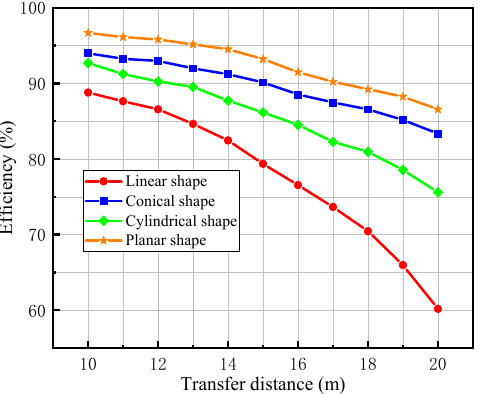
Figure 11. Comparison of transmission efficiency among four transfer structures at different distances.